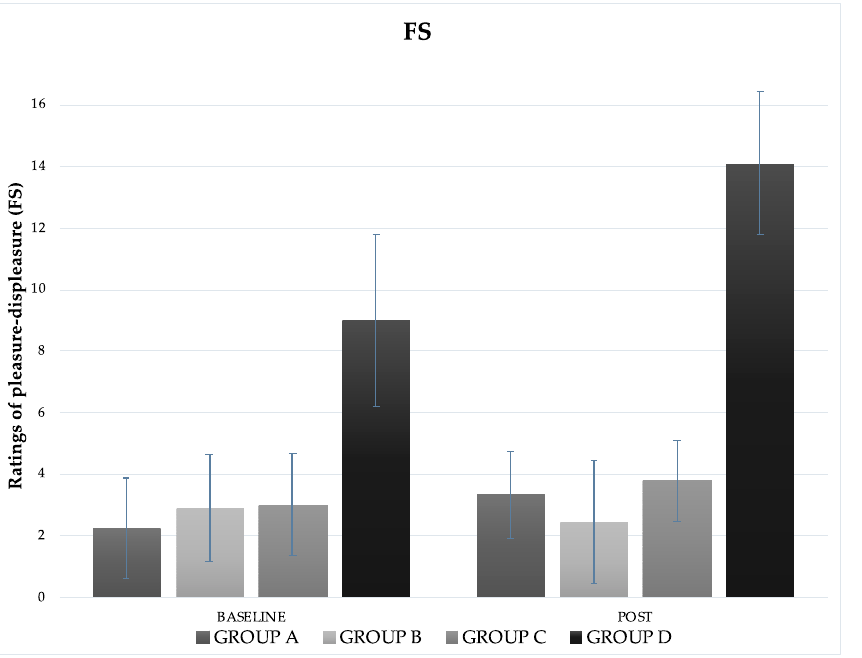
Figure 2. Mean ± SD of pleasure–displeasure ratings (Feeling Scale, FS) measured before and after the intervention.